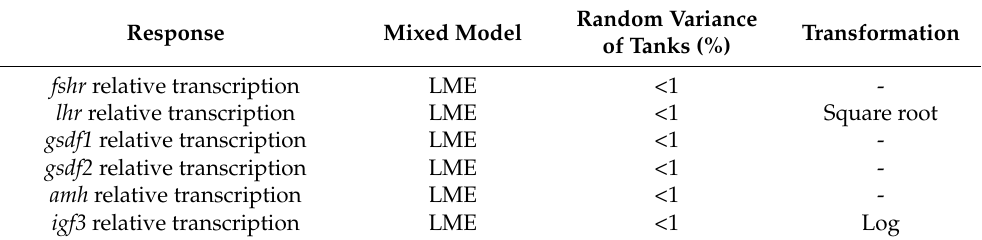
Table 2. Model used, percentage of total model variance identified as random variance caused by tank replicates, and transformations of the response variable applied. All models were fitted versus temperature, photoperiod, time, and their resulting two-way interactions.